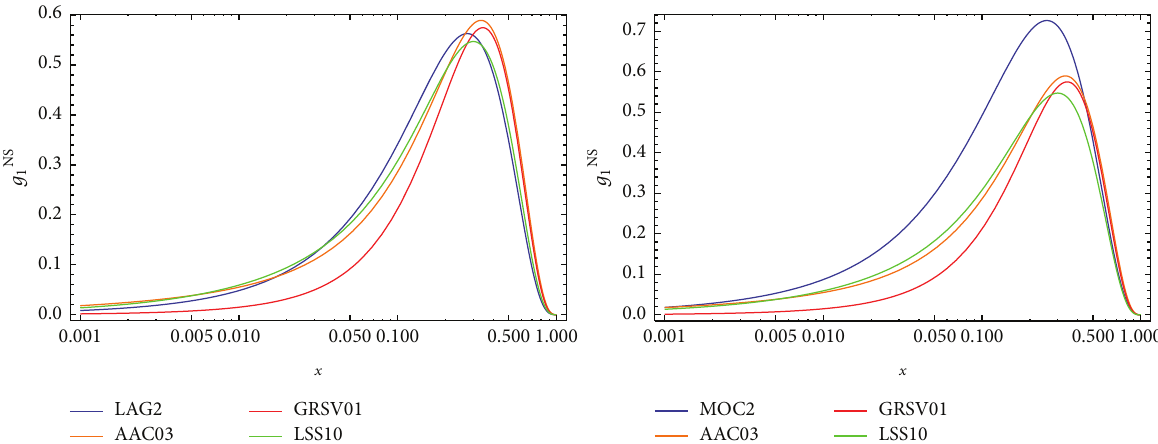
Figure 1: Polarized nonsinglet structure function 𝑔 NS 1 (𝑥,𝑡) as function of 𝑥 at 𝑄 2 = 2 GeV 2 at NLO, resulting, respectively, from our analytical calulations and their comparison with global fits to test the accuracy of our calculation.